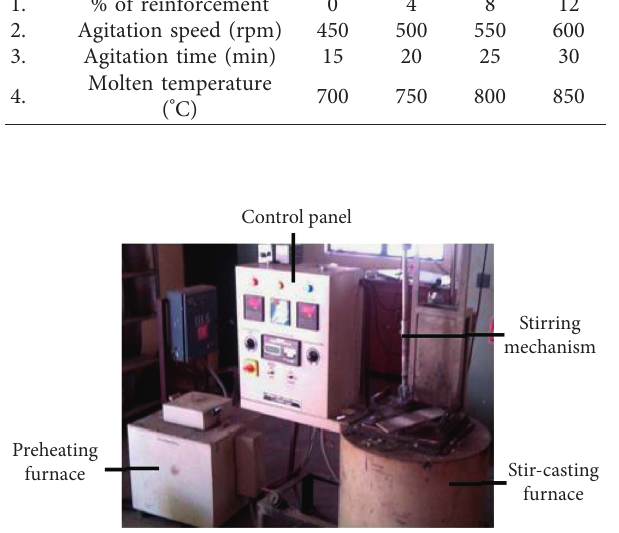
Figure 1: Stir-casting process equipment and setup.